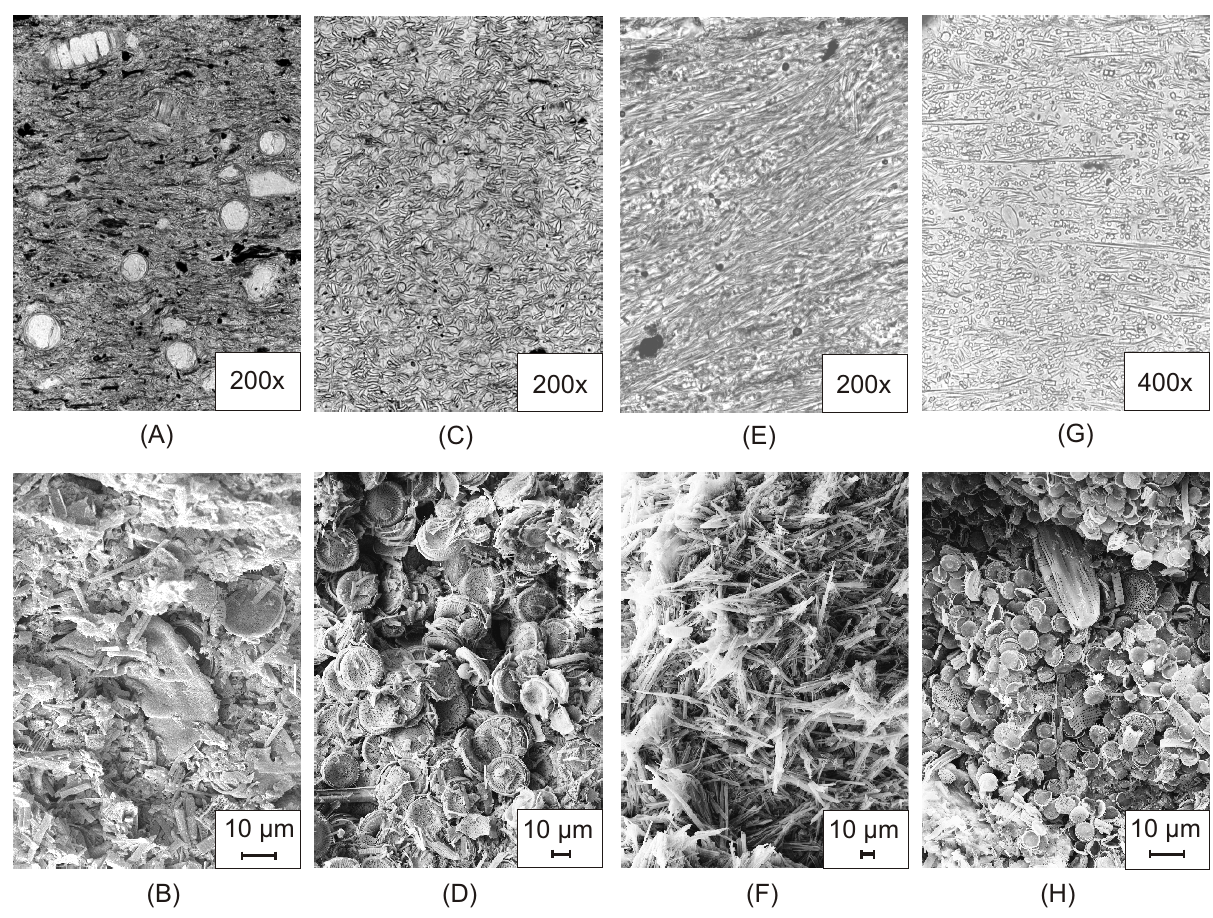
Fig. 3. Thin-section and scanning electron microscope photographs from different varve sub-layers from Dethlingen: (A, B) dark sub- layer; (C, D) light sub-layer type A; (E, F) light sub-layer type B; (G, H) light sub-layer type